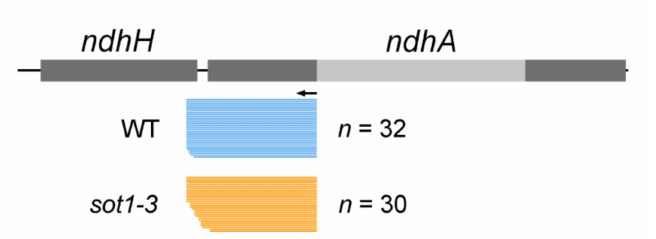
Figure 3. The loss of SOT1 leads to staggered 5 (cid:48) ends in ndhA transcripts. The 5 (cid:48) ends of ndhA transcripts were identified using a 5 (cid:48) -rapid amplification of cDNA ends (RACE). The 5 (cid:48) ends deduced from the RACE clones in the wild type (WT; blue bars), and sot1-3 (orange bars) are displayed below the gene model. Each bar represents a single RACE